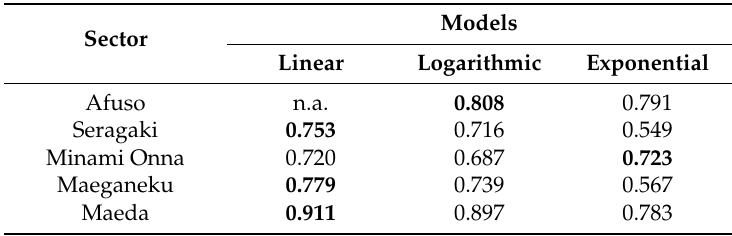
Table 3. Coefficient of determination for three models for the five sectors along the Onna coast, Japan. The largest values are in bold. n.a. indicates the model that did not ensure normality.